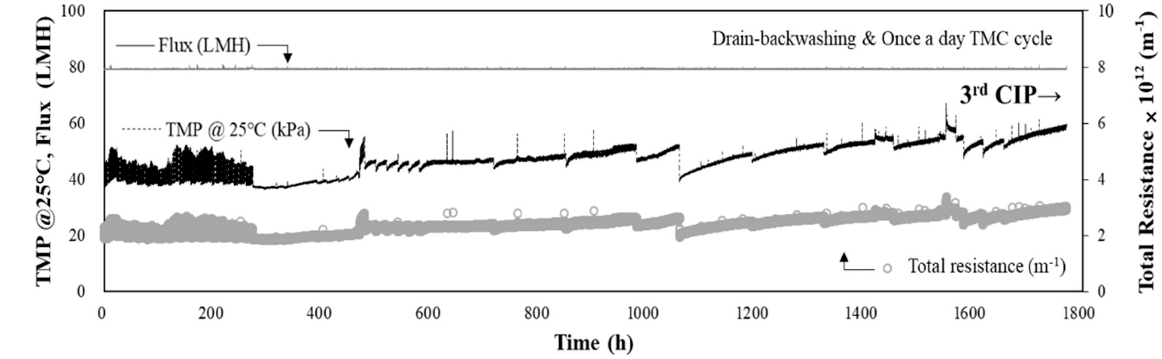
Figure 6. TMP and total resistance during the operation of DAF-MF combined process with high-turbidity raw water (max. turbidity = 81.3 NTU, coagulant dose =60 mg/L, hydraulic loading rate = 15 m/h, flux =80 LMH) .